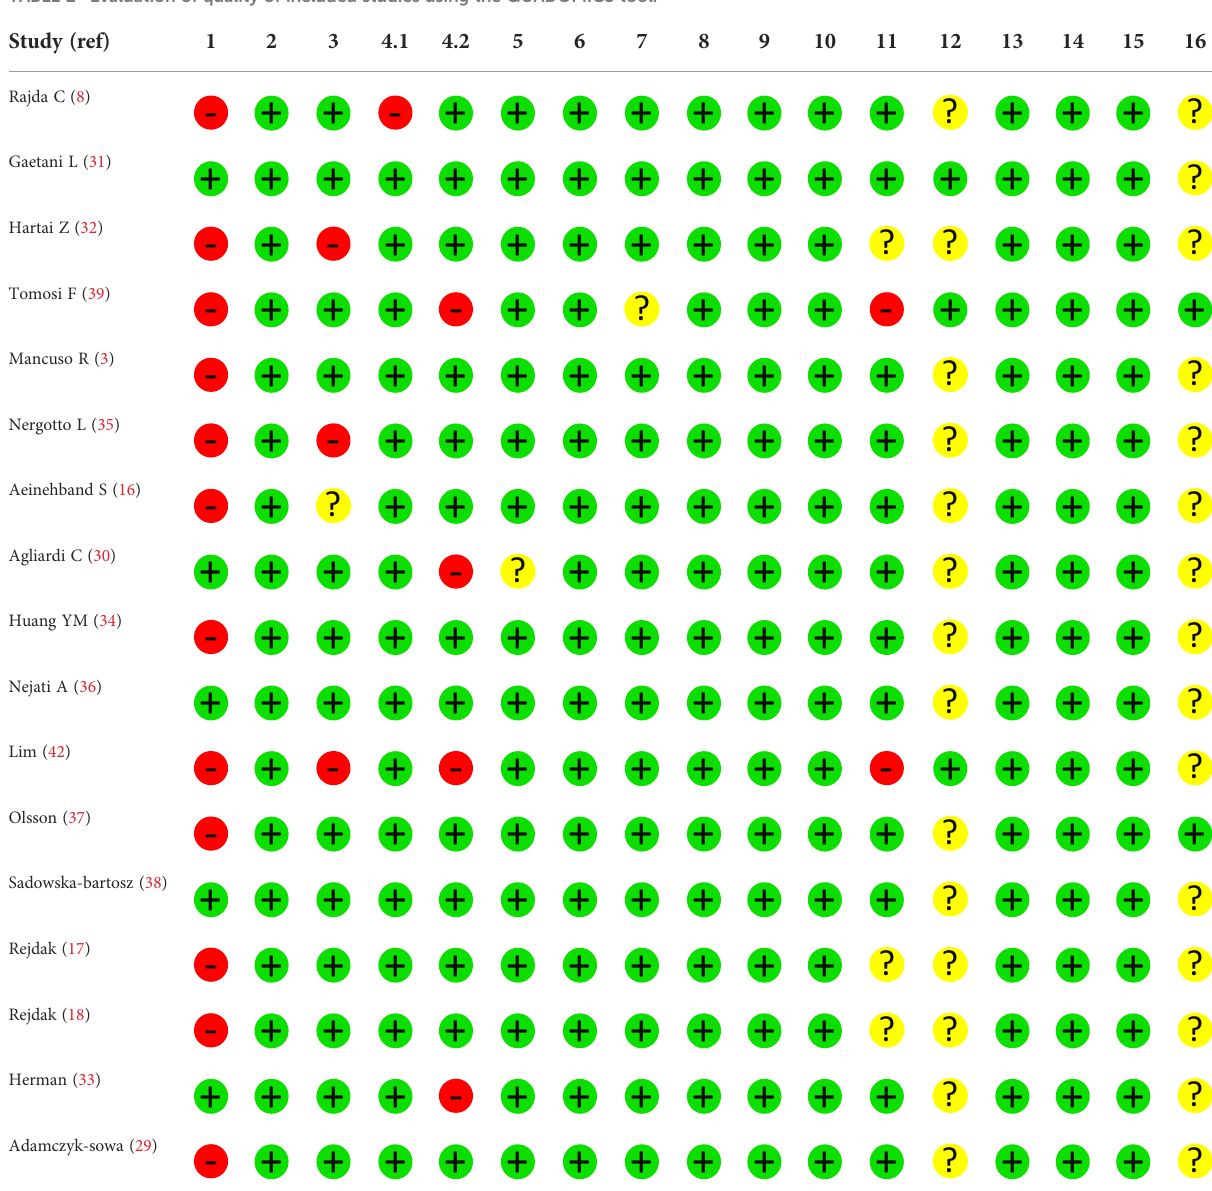
TABLE 2 Evaluation of quality of included studies using the QUADOMICS